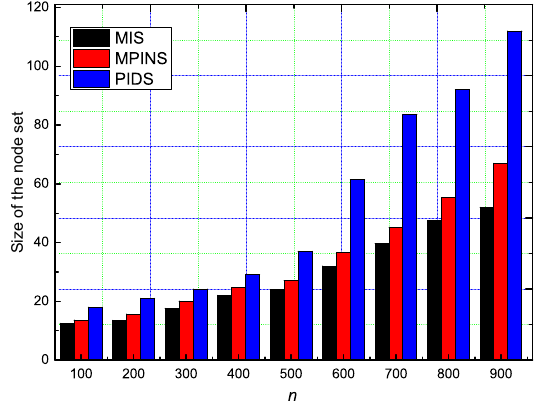
Fig. 6 Size of the node set: The default settings are p = 0.5 and (cid:18)(cid:18)(cid:18) = 0.5.